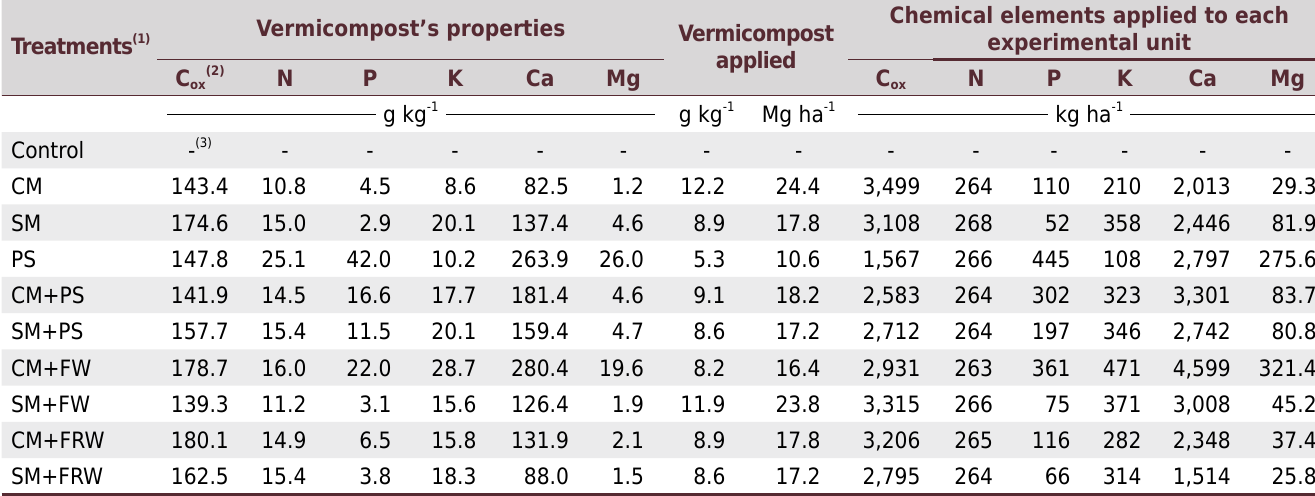
Table 1. Chemical properties of the vermicompost, amount of vermicompost applied to each experimental unit, and the respective amounts of chemical elements applied to each experimental unit Vermicompost’s Treatments (1)